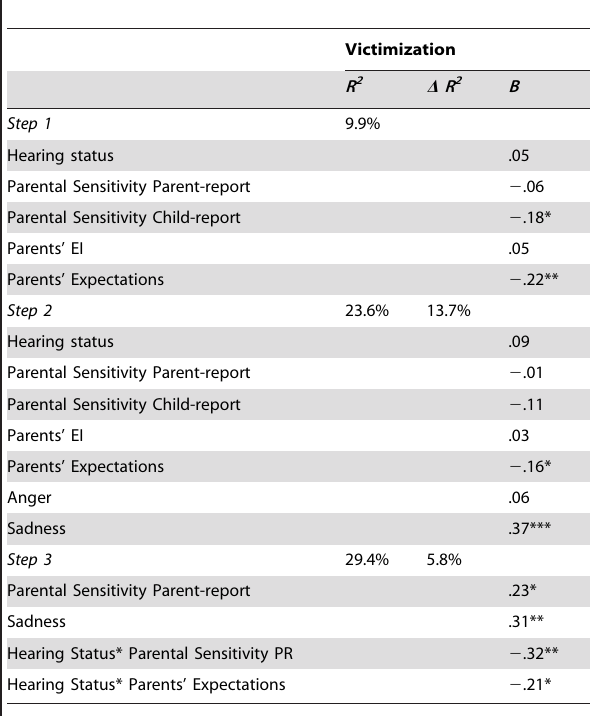
Table 6. Hierarchical Regression Analysis predicting Victimization from Parental and Child